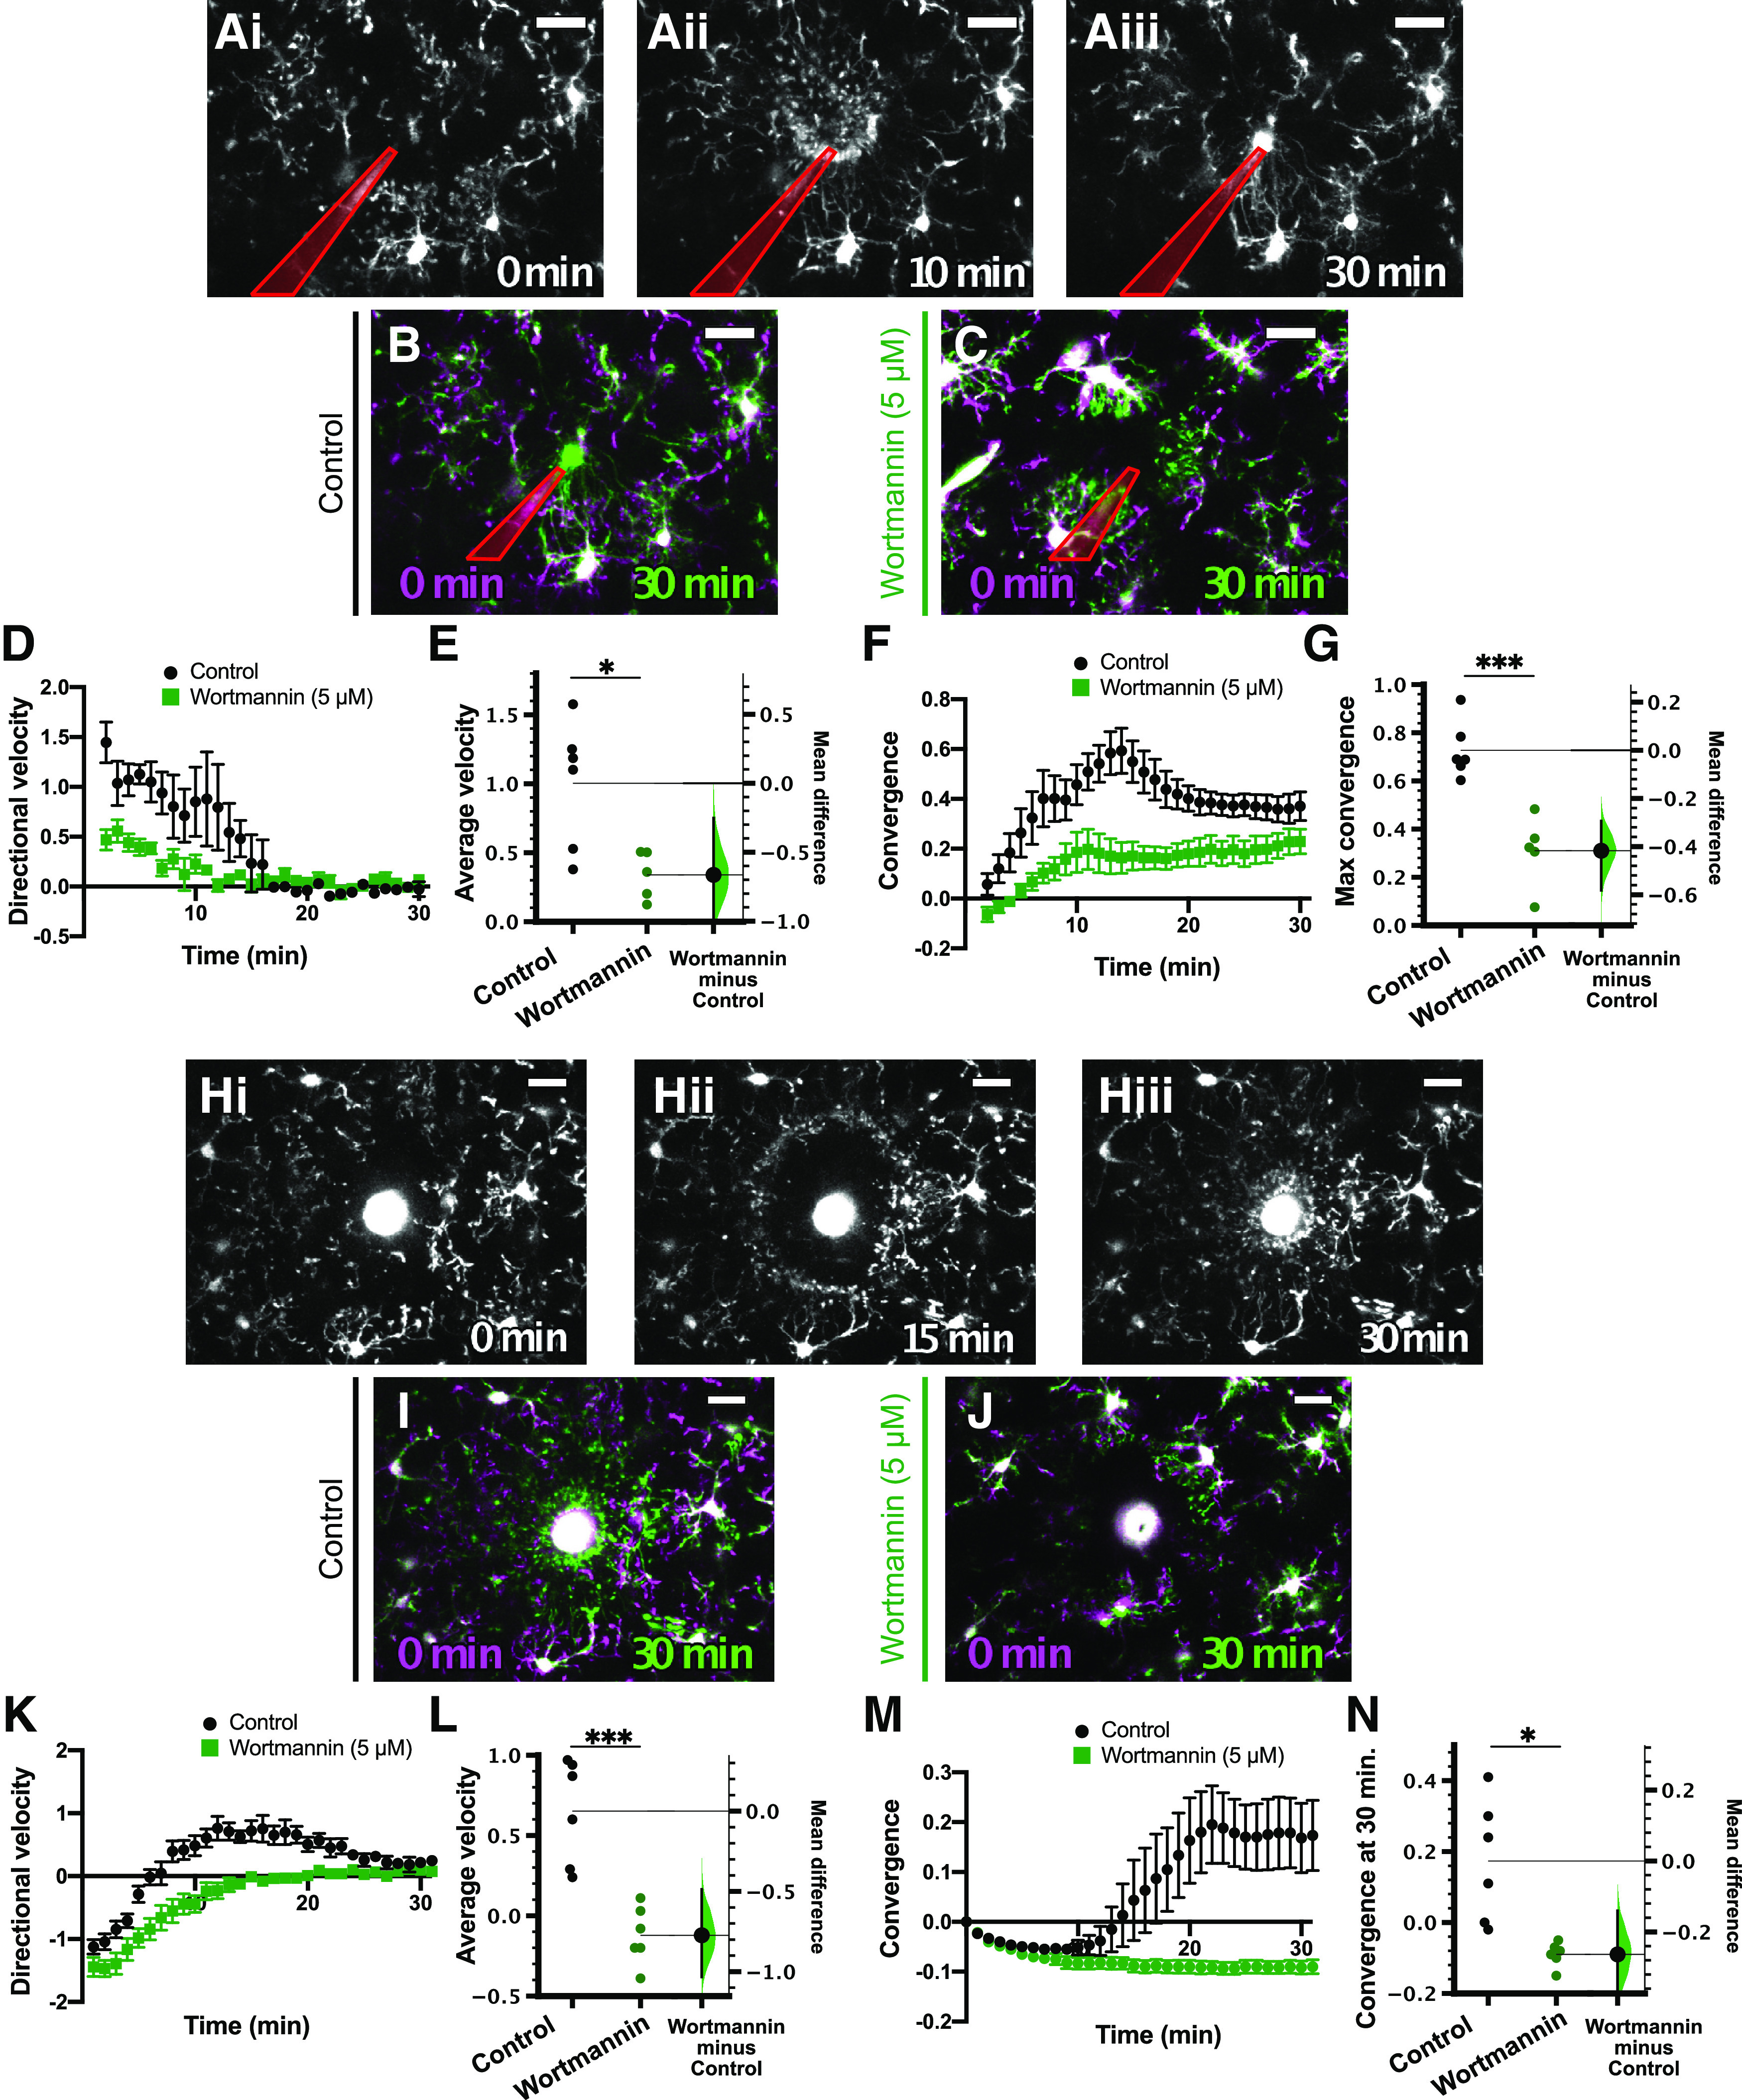
 Pan-PI3K inhibition blocked the microglial response to focal laser injury in acute cortical slices. A, Representative images of the microglial response to focal ATP release in a control (0.1% DMSO vehicle) slice at 0 min (Ai), 10 min (Aii), and 30 min (Aii) after ATP puff. B, C, Overlays of representative responses from control (B, overlay of Ai and Aiii), 5 μm wortmannin-treated (pan-PI3K inhibitor; C) slices at the indicated time points. Images at later time points (green) are overlaid with initial images (t = 0 min, magenta). In A–C, the pipette is outlined in red. D, Time course of directional velocity, with one frame acquired every 1 min. Quantification begins at t = 2 min (two frames after puff) to avoid artifacts from the dye included in the pipette solution which leaks into the imaging field at earlier time points. E, The mean difference between control and Wortmannin-treated groups is shown in the Gardner–Altman estimation plot. Both groups are plotted on the left axes; the mean difference is plotted on a floating axes on the right as a bootstrap sampling distribution. The mean difference is depicted as a dot; the 95%CI is indicated by the ends of the vertical error bar. Wortmannin significantly blocked the directional response [comparisons made on average velocity calculated in the interval of 2–10 min after ATP presentation; unpaired t test, p = 0.014; unpaired mean difference is −0.665 (95%CI −0.991, −0.253)]. F, Time course of convergence. Maximum convergence was used for statistical comparisons because microglial processes enter the pipet tip after convergence, decreasing this value. G, Wortmannin reduces the maximum convergence as shown in the Gardner–Altman plot [unpaired t test, p = 0.0006; unpaired mean difference is −0.417 (95%CI −0.582, −0.294)]. H, Representative images of the microglial response to laser injury (bright circular feature in the center of image) in a control cortical slice immediately after injury (Hi; 0 min), as the microglial processes moved toward the injury site (Hii; 15 min), and after the microglial processes converged on the injury site (Hiii; 30 min). I, Overlay of images of the microglial response at 0 min (Hi; magenta) and at 30 min (Hiii; green) demonstrating convergence of processes around the injury after 30 min. J, Similar overlay showing the microglial response to laser injury in a wortmannin-treated (5 μm) slice at 0 min (magenta) and 30 min (green) after the injury. Microglial processes did not converge around injury as shown by the lack of green pixels around the core. K, Time course of the directional velocity in control (black circles) and wortmannin-treated (green squares) slices showing that wortmannin substantially decreased the motility directed toward the ablation core. Note that the negative directional velocity that occurs soon after ablation is an artifact of tissue deformation following the laser injury. L, Comparison of the average velocity from 10 to 20 min (encompassing the peak of the response) showed significant decrease in the wortmannin-treated group [unpaired t test; p = 0.0005; unpaired mean difference is −0.773 (95%CI −1.03, −0.487)]. M, Time course of convergence in control and wortmannin-treated slices. N, Comparison of the convergence at 30 min showed a significant decrease in the wortmannin-treated group [Welch’s t test; p = 0.013; unpaired mean difference is −0.263 (95%CI −0.4, −0.14)]. n = 6 control slices, 5 wortmannin-treated slices; from 6 animals total for focal ATP release experiments. n = 6 control slices, 6 wortmannin-treated slices; from 6 animals total for laser injury experiments; *p < 0.05, **p < 0.01, ***p < 0.001. Data are presented as mean ± SEM. Scale bar: 20 μm. Additional information on the calculation of directional velocity is provided in Extended Data Figure 1-1 and Movie 9.